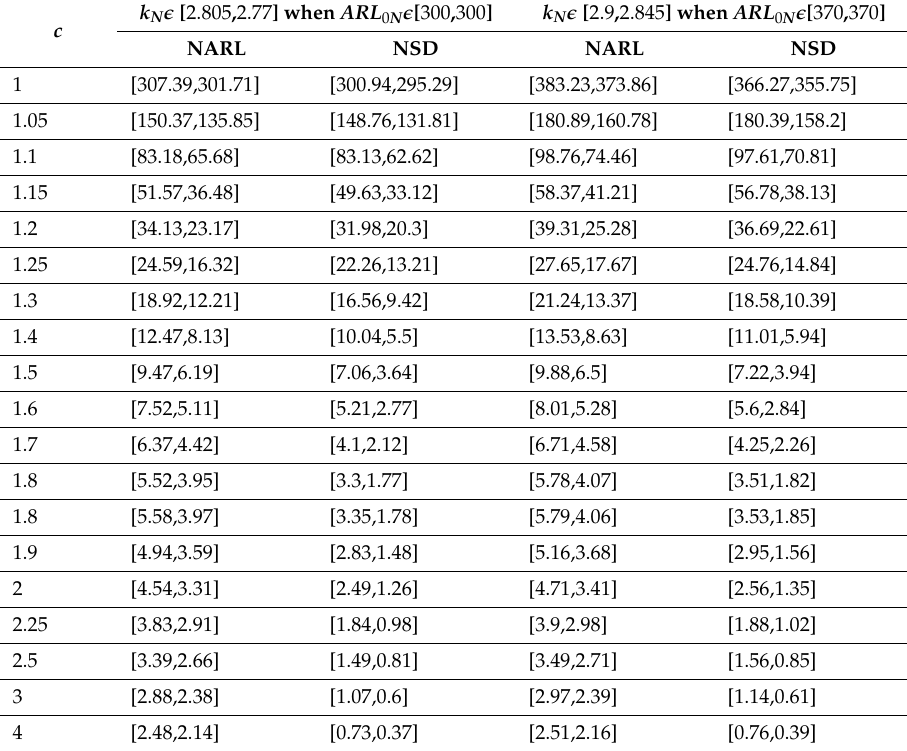
Table 4. The neutrosophic average run length (NARL) when n N (cid:15) [3, 5] and λ N (cid:15) [0.28, 0.32].